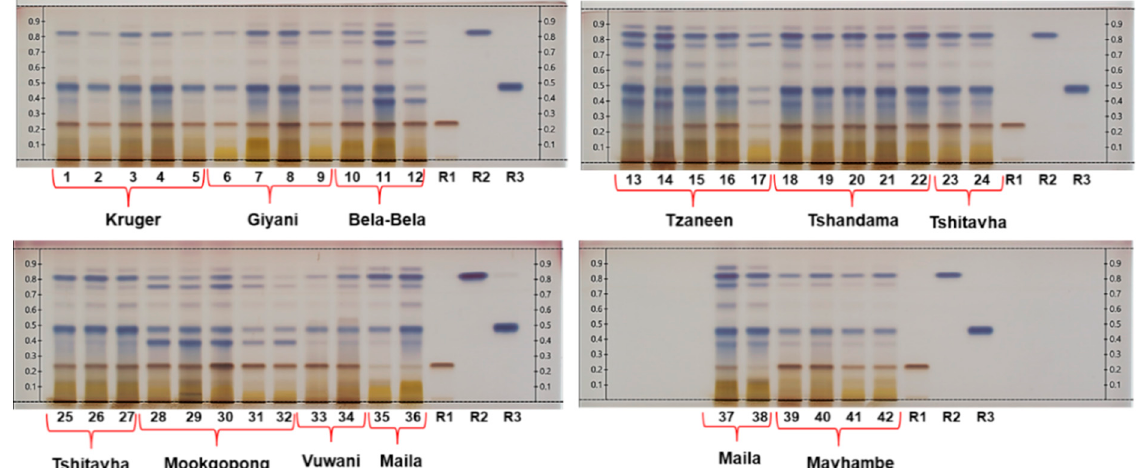
Figure 1. HPTLC fingerprints of the dichloromethane: methanol (1:1) extracts of T. sericea samples from 10 different localities (Tracks 1–42). The extracts were applied at the same concentration and the plates were developed using dichloromethane: ethyl acetate: methanol: formic acid (90:10:30:1). Three standards (Track R1 (resveratrol-3- O - β -rutinoside), Track R2 (sericic acid) and Track R3 (sericoside) were included on the plates, which were viewed under white light after derivatisation with 10% sulfuric acid in